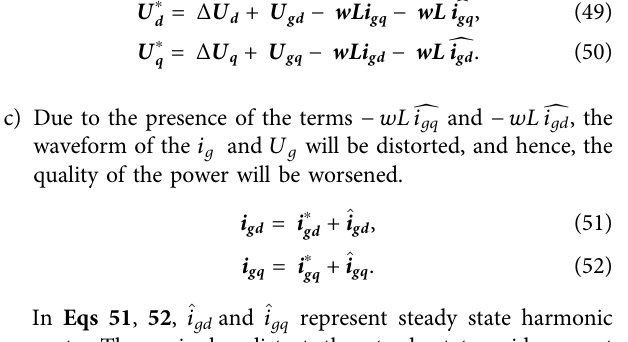
Frontiers in Energy Research |